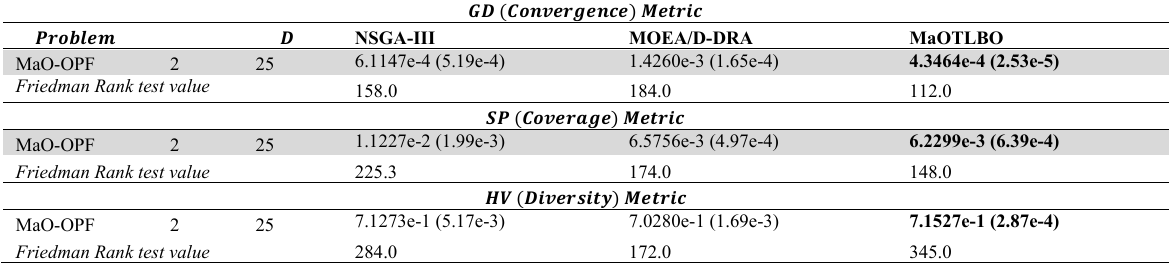
Fig. 9. GD and HV versus the number of function evaluations curve using MaOTLBO, NSGA-III, and MOEA/D-DRA optimizers The GD, SP, Friedman rank test, and HV comparison based on the MaO-OPF problem using MaOTLBO, NSGA-III, and MOEA/D-DRA